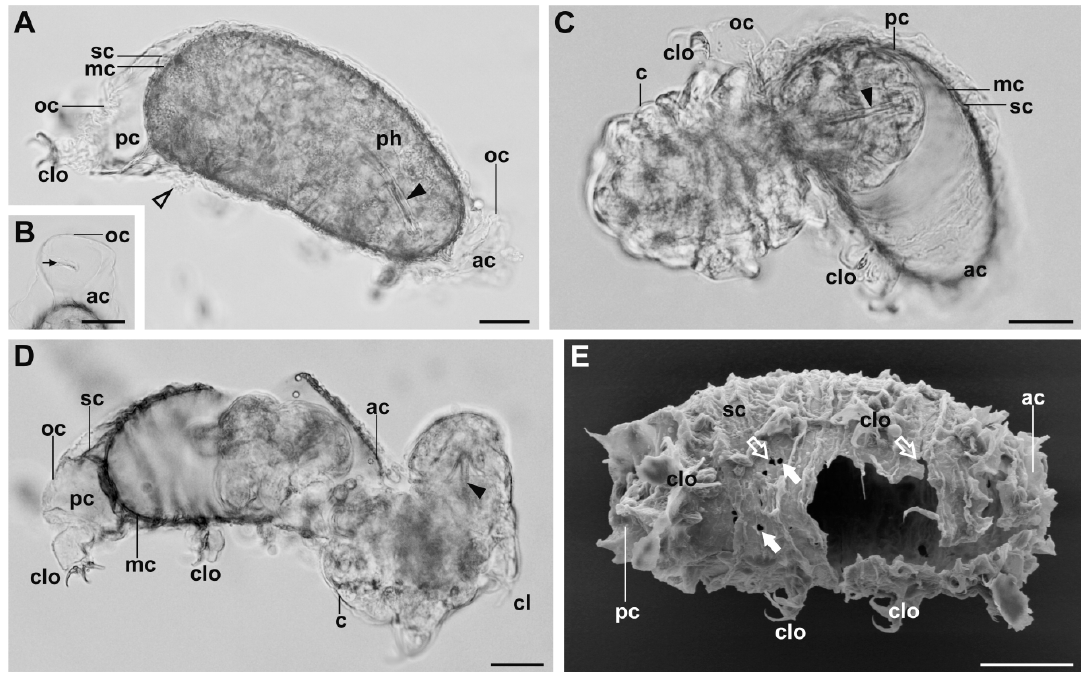
Figure 2. Cyst structure and excystment. ( A ) Twenty four ‐ hour old cyst in vivo, lateral view, BF; ( B ) anterior part of the cyst in vivo, ventro ‐ lateral view, BF; ( C,D ) excystment; ( C ) leaving the cuticular capsule through the posterior part of the cuticular capsule, in vivo, BF; ( D ) leaving the cuticular capsule through the anterior part of the cuticular capsule, in vivo, BF; ( E ) empty cuticular capsule, ventro ‐ lateral view, SEM. Scale bars 25 μ m. Note that the old cuticle is only in the form of the remains of cuticle with claws. Anterior part of the cyst/cuticular capsule (ac); cuticle of the animal (c); claws of the animal (cl); claws of the old cuticle (clo); mummy cuticle (mc); old cuticle (oc); posterior part of the cyst/cuticular capsule (pc); pharynx (ph); sarcophagus cuticle (sc); cuticle of the hindgut (empty arrowhead); buccal ‐ pharyngeal apparatus of the animal (filled arrowhead); increase in damage (thick empty arrow); round holes made by claws (thick filled arrow); closed mouth opening of the old cuticle (thin arrow).